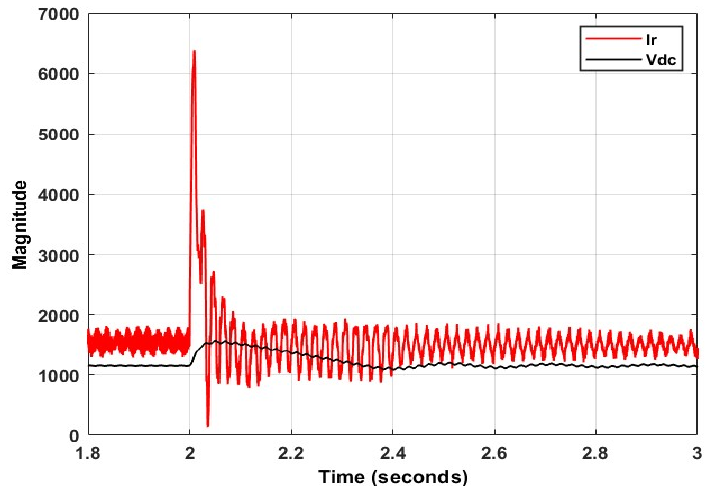
Figure 3. Rotor response with a 20 Ω crowbar.